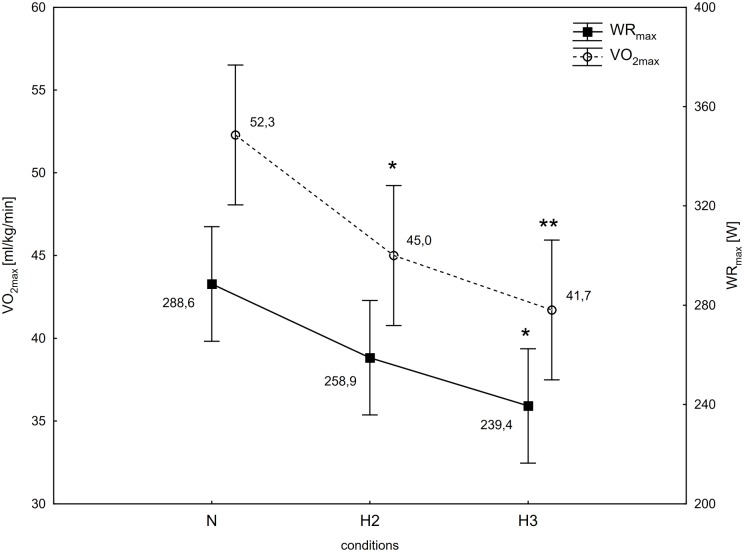
Maximal oxygen uptake (VO2max), and maximal workload (WRmax) during incremental test performed in different conditions.N-normoxia, H2-hypoxia 2,000 m, H3-hypoxia 3,000 m; * p<0.05, ** p<0.01—statistically significant differences in relation to N.